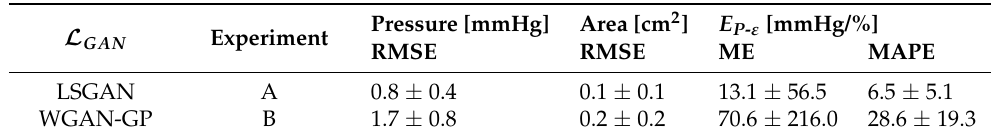
Table 2. Mean standard deviation of error for Brachial–Radial to Aortic Abdominal case on the ± test set.